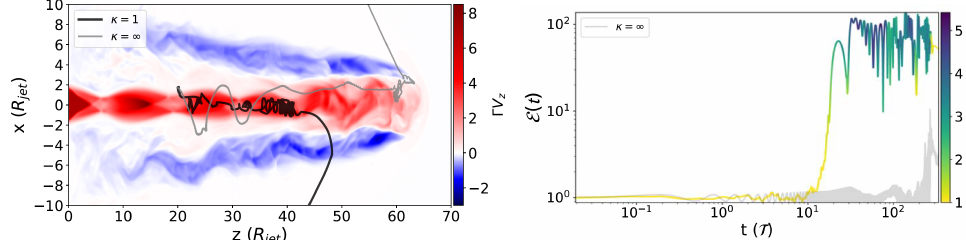
Figure 16. Left: Two-dimensional projection of exemplary trajectories of energetic particles, injected with initial Larmor radius r L ∼ r j /14 into the simulated MHD jet environment. Right: Evolution of the relative energy gain of these particles, (cid:101) , in terms of their initial relativistic gyro-period τ , colour-coded with the Lorentz factor Γ pr probed. In 3d, the particle following the grey trajectory, only experiences, in the absence of scattering ( κ = ∞ ), some moderate velocity differences (hence, gains) towards the end, and eventually becomes unconfined (escapes) as the initial jet magnetic field is assumed to decrease, approximately as B ( z ) ∝ 1/ z along the jet, and a toroidal field scaling B ( r ≥ r j ) ∝ 1/ r and B ( r ≤ r j ) ∝ r has been employed. The particle following the black trajectory undergoes strong spatial (Bohm) diffusion ( κ = 1), experiences the fast jet spine and significantly gains energy (by up to a factor of ∼ 100) in these interactions. From ref. [135] (©AAS. Reproduced with